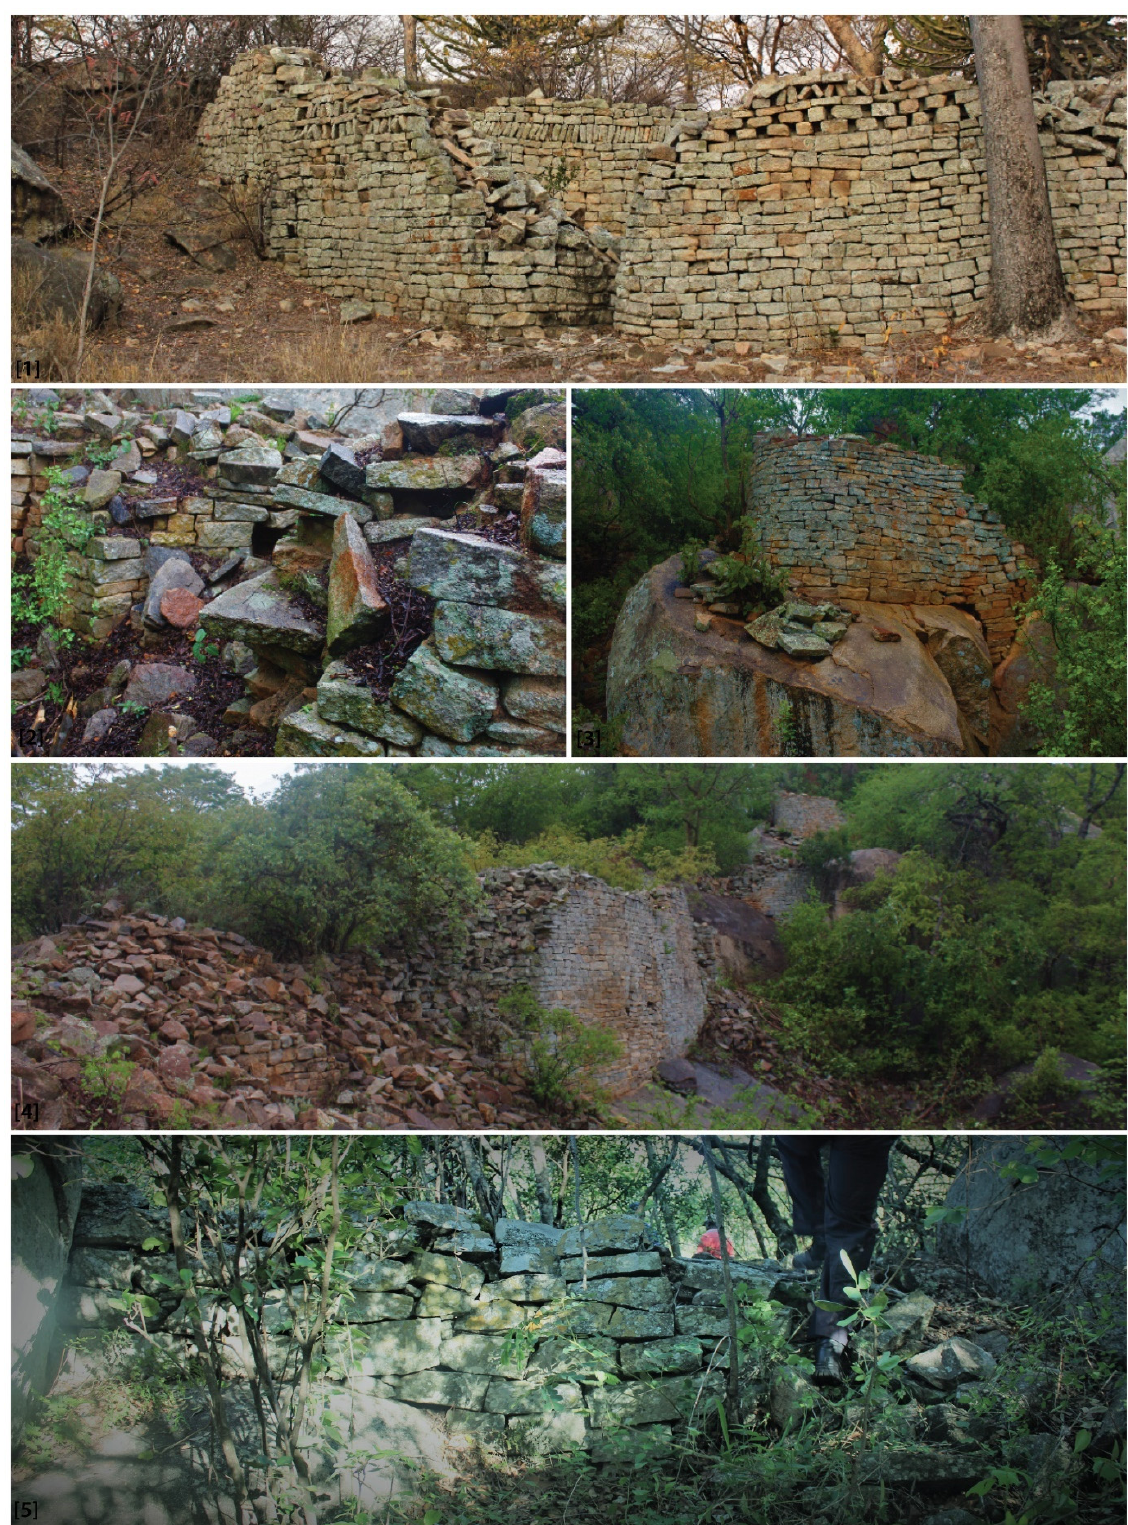
Figure 4. ( 1 ) Dry stone walling at Kongezi showing a rounded entrance and designs of herringbone, check, cord, chevron, and chessboard patterns. ( 2 ) Remnants of a squared entrance with dolerite lintel stone slabs recorded at Chumnungwa. ( 3 ) Remnants of a conical buttress with steps recorded at Chumnungwa. ( 4 ) The main free-standing walls encircling the northern end of Chumnungwa hill summit. ( 5 ) Part of the walling recorded at the Mutabvuri homestead.